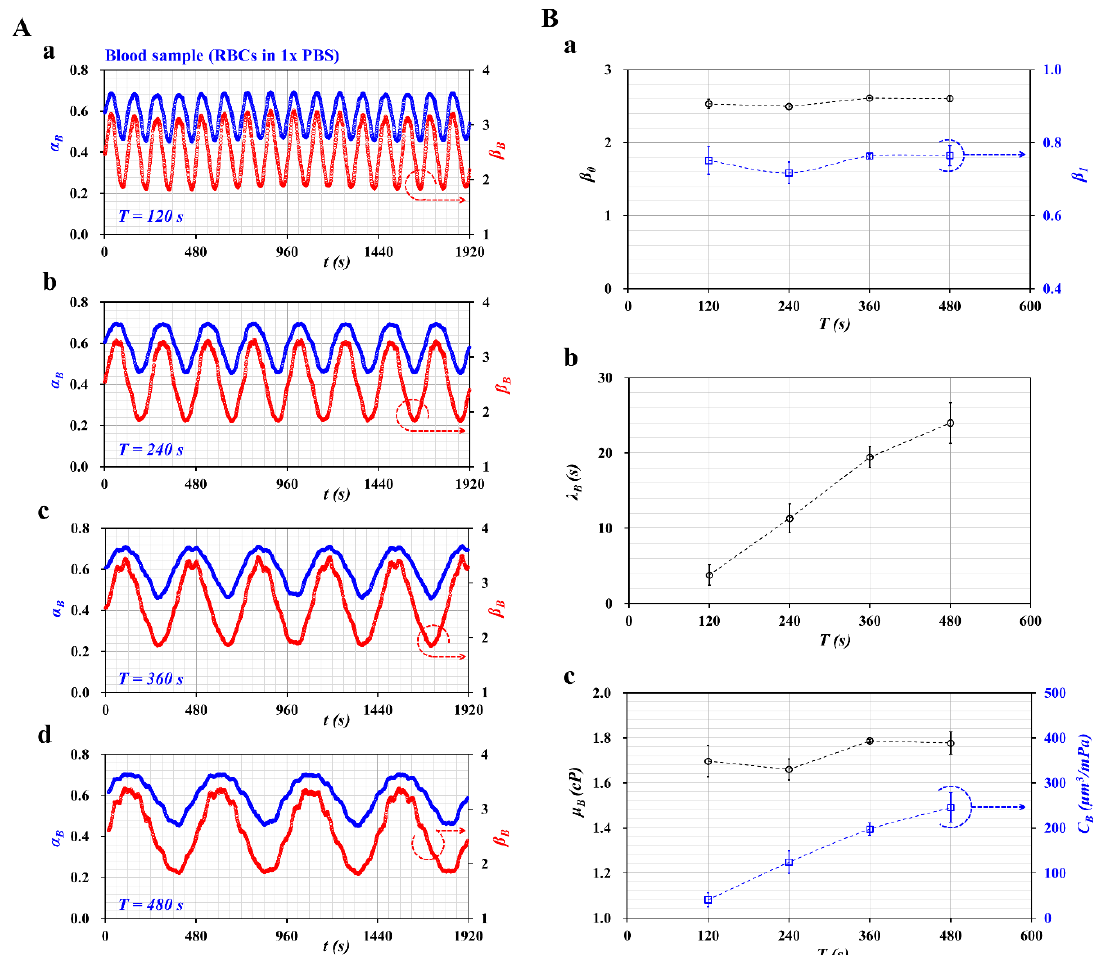
Figure 3. Evaluation of the effect of period ( T ) on viscoelasticity (blood viscosity and compliance). ( A ) Temporal variations of α B and β B with respect to period ( T ) (( a ) T = 120 s, ( b ) T = 240 s, ( c ) T = 360 s, and ( d ) T = 480 s). ( B ) Quantification of viscosity ( μ B ) and compliance ( C B ) with respect to period. ( a ) variations of β 0 and β 1 with respect to T , ( b ) variations of λ B with respect to T , and ( c ) variations of μ B and C B with respect to T .